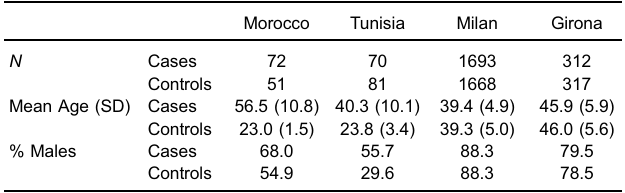
Table 1. Baseline characteristics of the